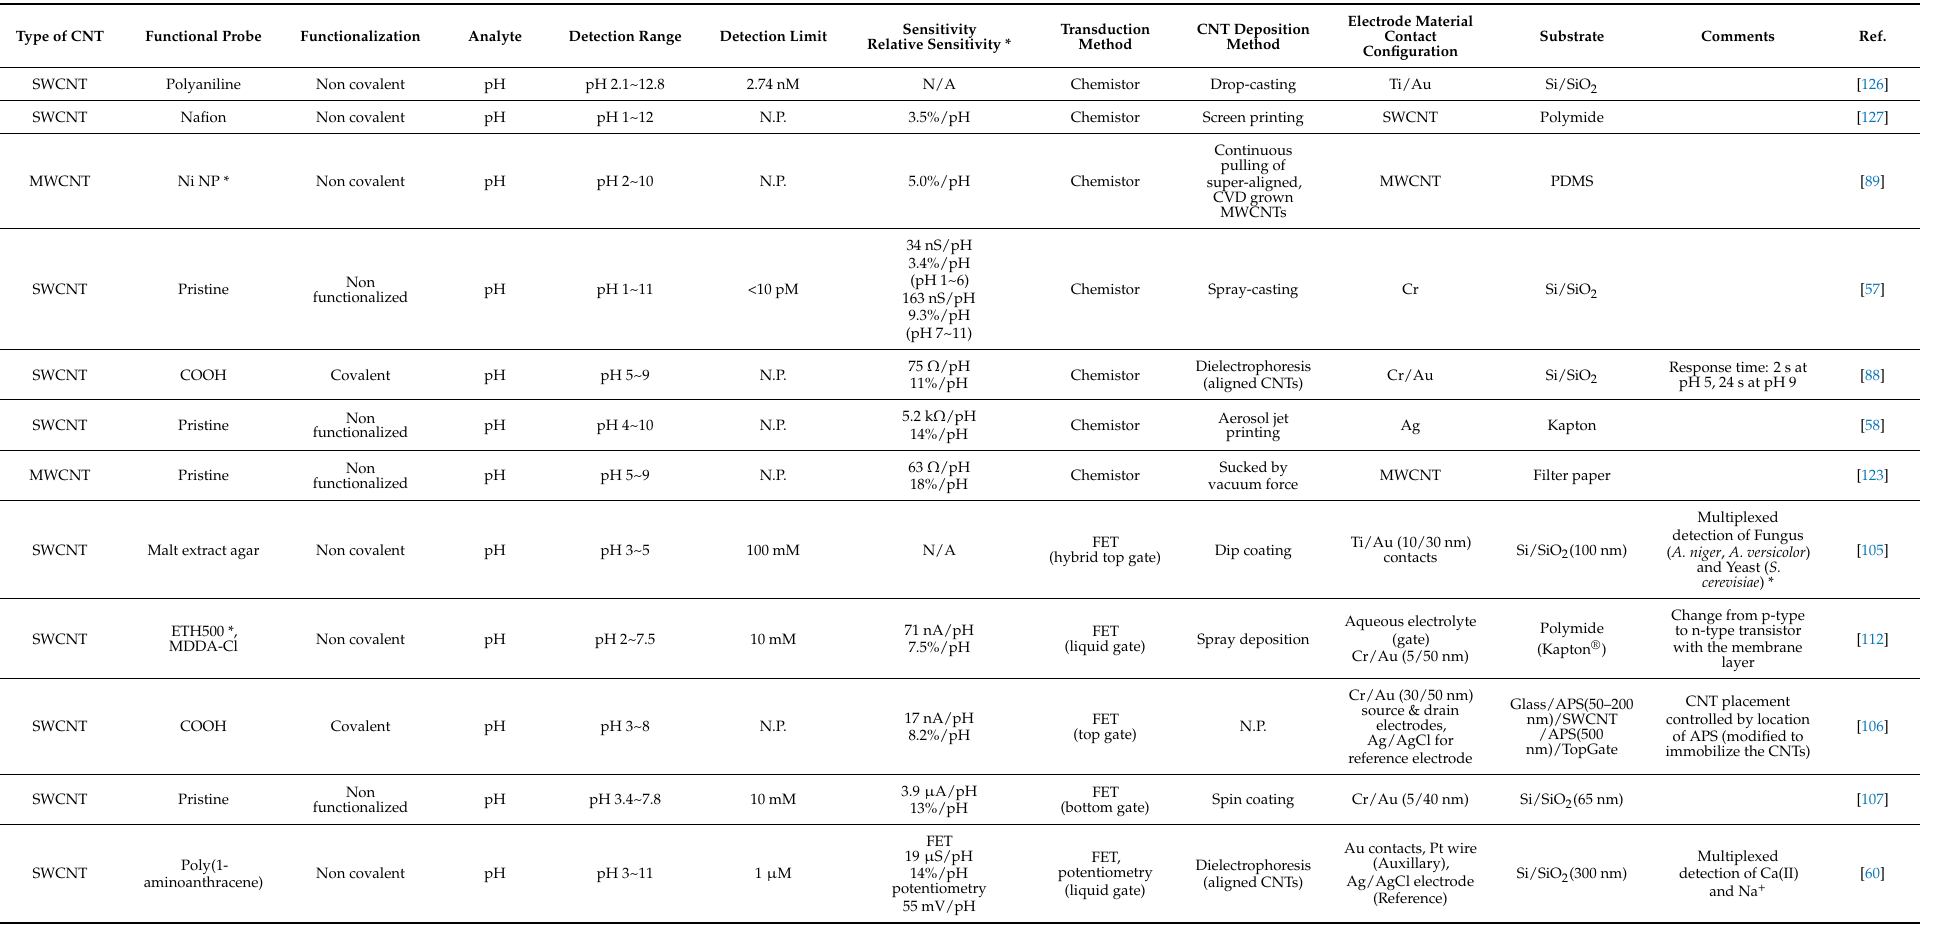
Table 2. CNT-based pH sensors in water, sorted by transduction type then by relative